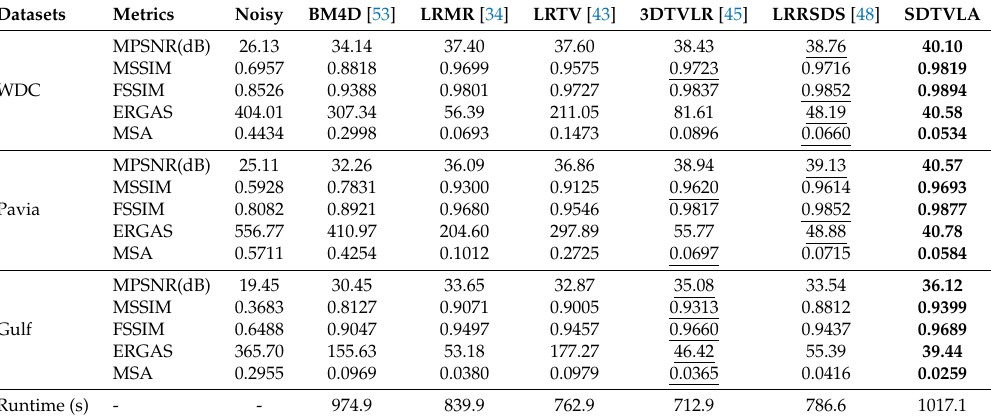
Figure 8. PSNR and SSIM values as a function of the band for the simulated datasets. ( a , b ) WDC dataset; ( c , d ) Pavia University dataset; ( e , f ) Gulf dataset. Table 2. Assessment metrics for different denoising methods in the simulated datasets (The optimal results are shown in bold and the suboptimal results are